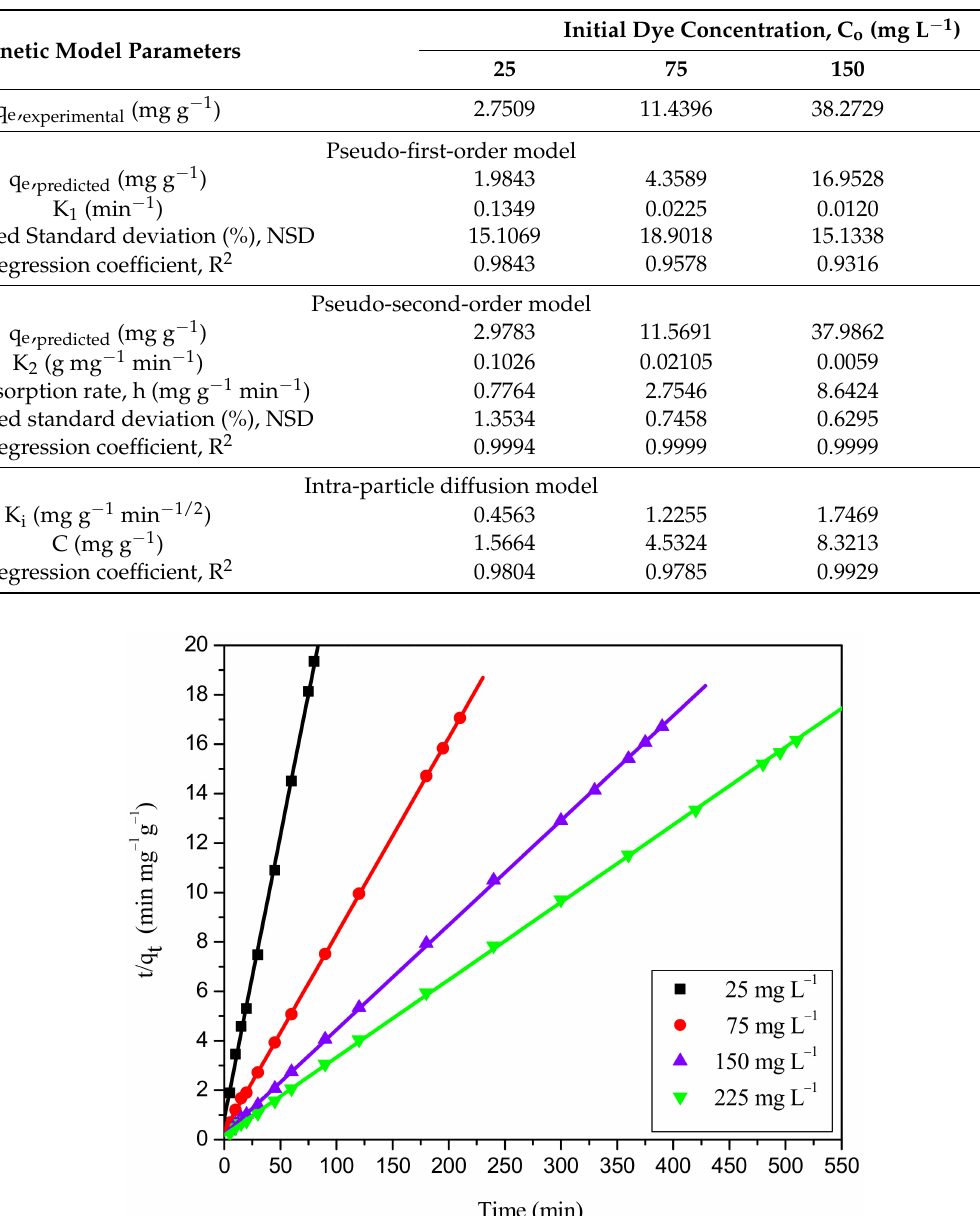
Table 9. Kinetic model parameters for the adsorption of RBBR dye onto WSBAC adsorbent.